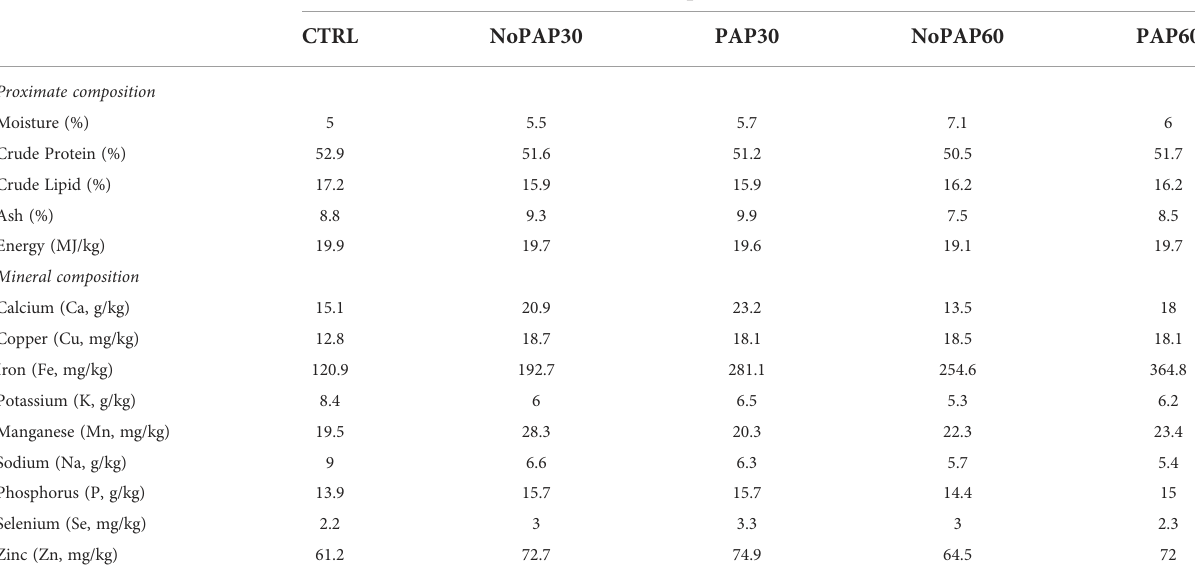
TABLE 2 Chemical composition of the fi ve experimental diets for market-sized turbot as